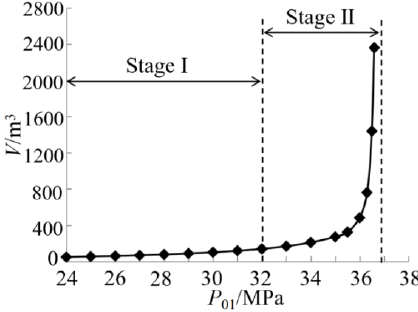
Figure 4. The relationship between P 01 and the range of the plastic zone (Plan 2).